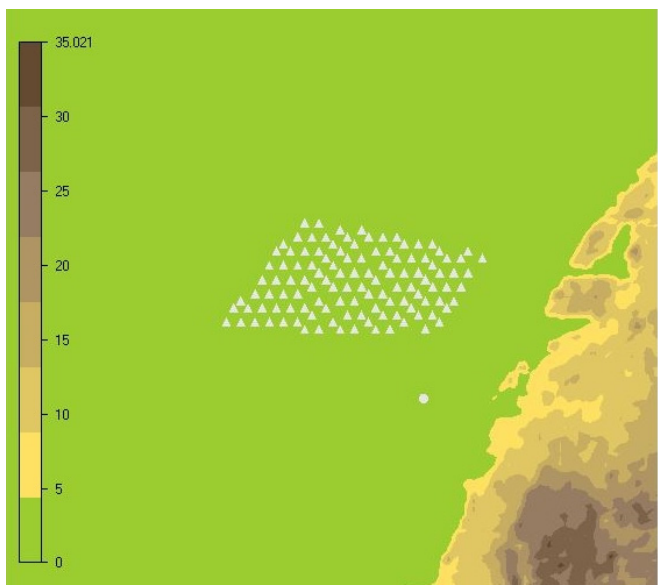
Figure 12. Turbine layout based on park optimization for 118 turbines.